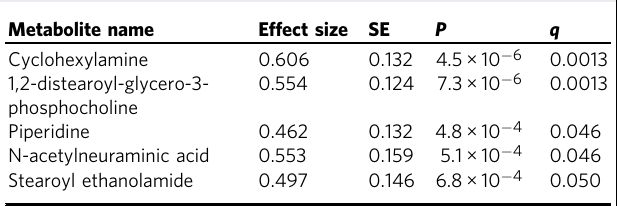
Table 2 Signi fi cant associations between the complications of T2D and the